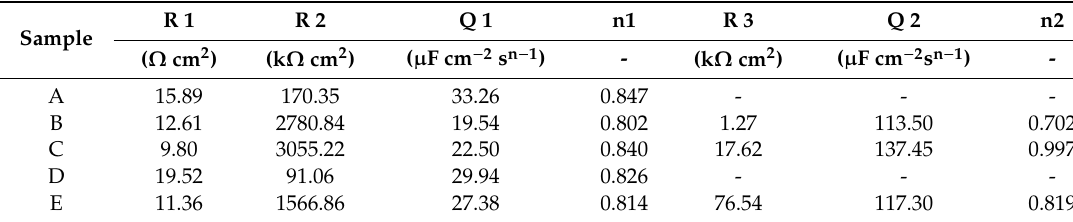
Table 7. Electrochemical impedance spectroscopy (EIS) parameters in NaCl 0.9%.